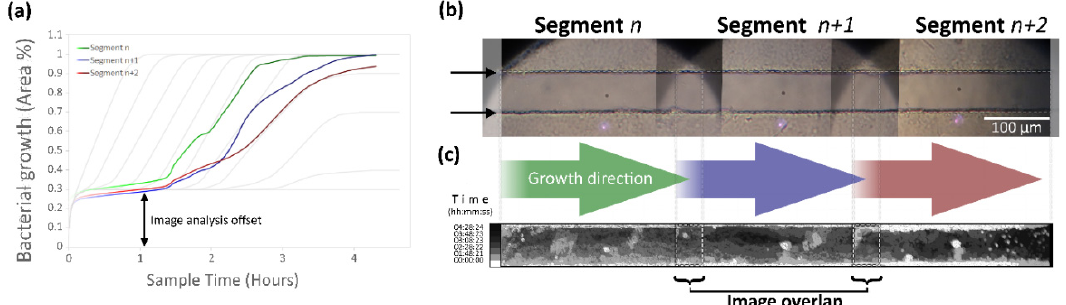
Figure 7. Image analysis for bacterial growth calculations (real data). ( a ) Recorded growth for the selected segments against time. The lag phase and image analysis offset can be seen. Notice that Segment n + 2 tends to stabilize below complete colonization of the microchannel segment. ( b ) Acquired image sample of selected segments without bacteria; the growth direction for each segment is indicated below each image. Segment n corresponds to a location of 1.5 mm from the culture chamber on the image. Black arrows at the left of the image indicate the microchannel edges. ( c ) Processed binarized images; the gray scale corresponds to different time points. The decrease in growth at Segment n + 2 and the overlapping area of the images can be seen.